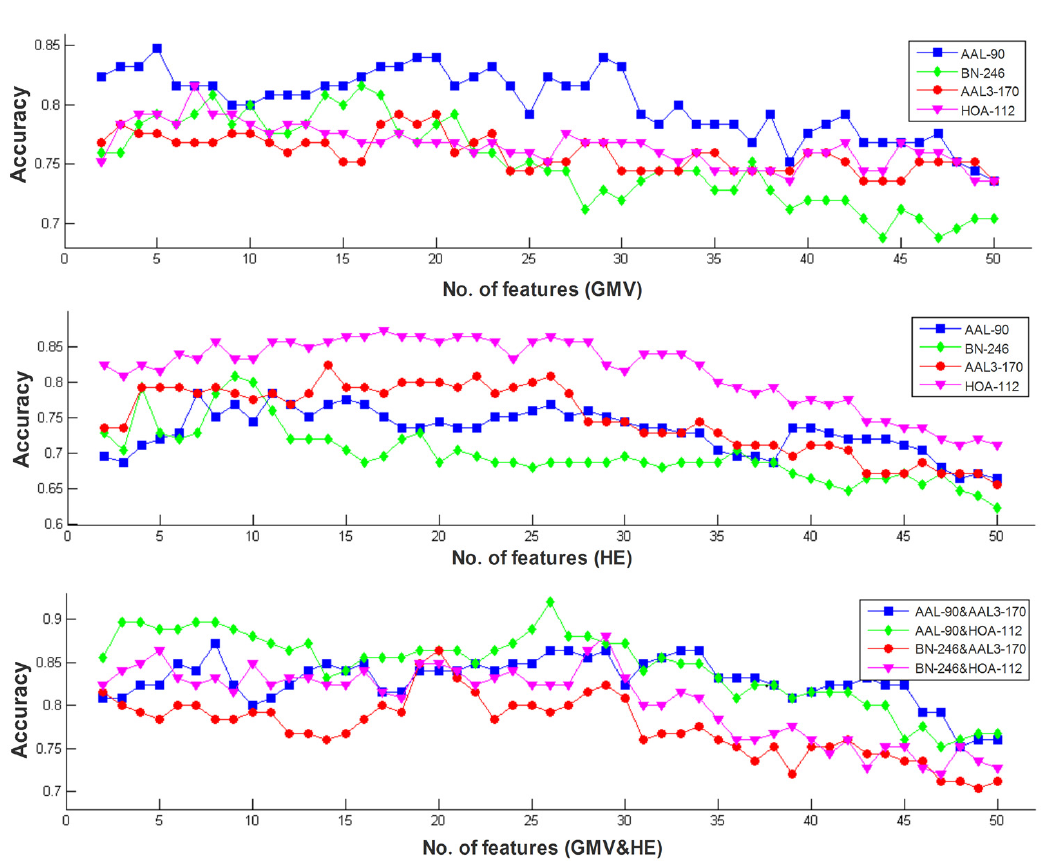
Figure 3. The best classification results with a different number of features ranging from 2 to 50 in single-modal and multi-modal data.